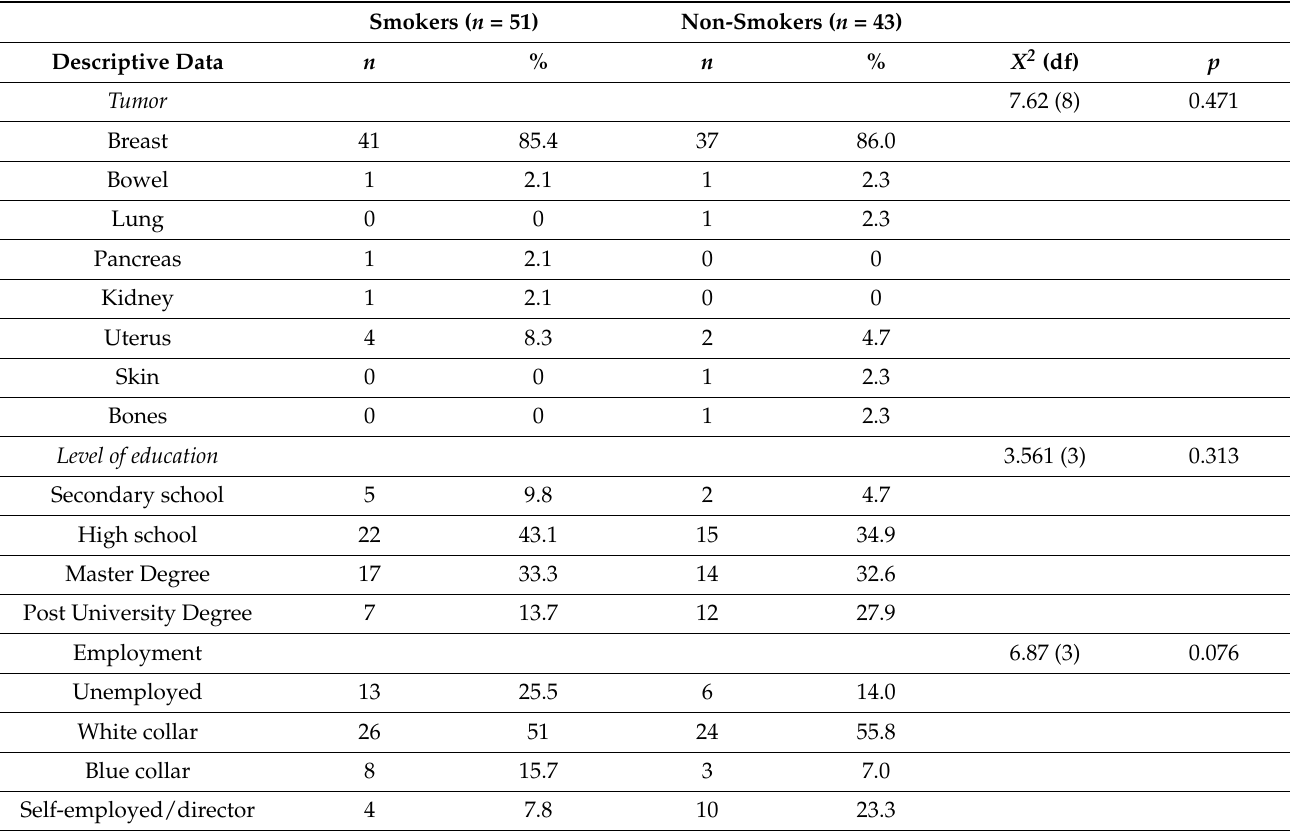
Table 1. Descriptive data of participants.